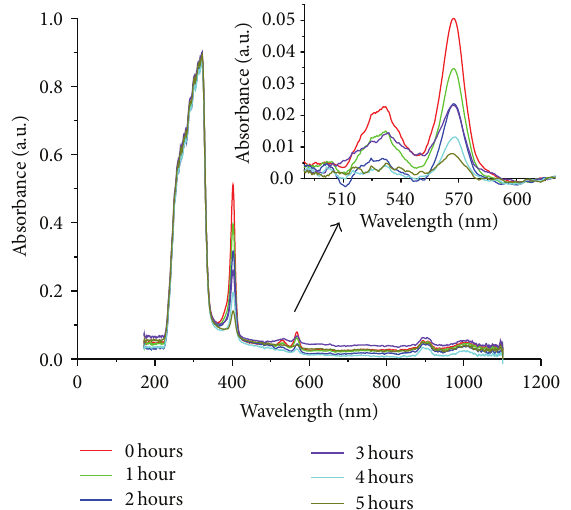
Figure 6: UV-Vis absorbance spectra as a function of irradiation time of the standard vanadium etioporphyrins solution in acetone. The insets show the bands observed at 530 nm and 569 nm with the background subtracted.